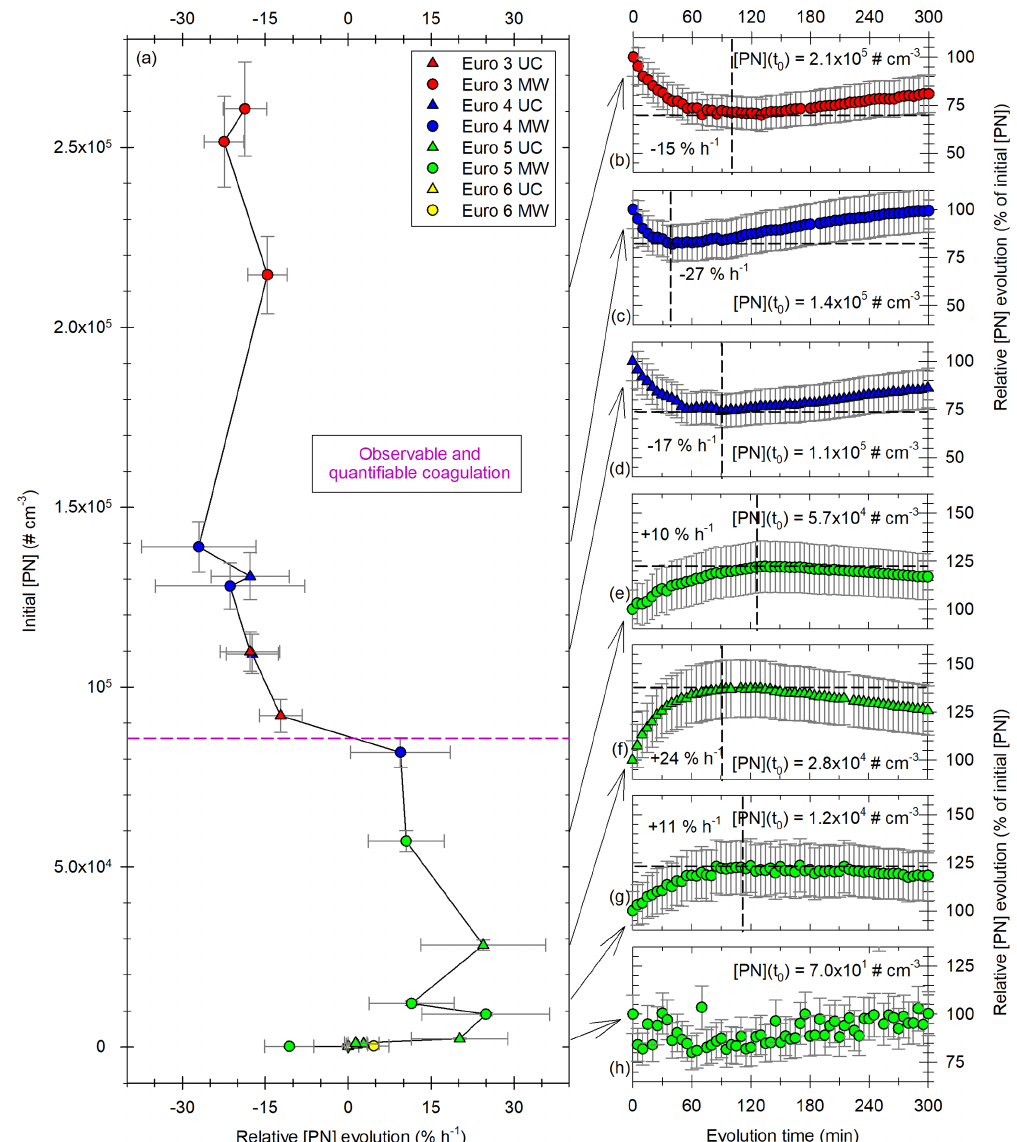
Figure 11. Evolutions of total [PN] for the vehicles of all Euro norms (Euro 3 in red; Euro 4 in blue; Euro 5 in green; Euro 6 in yellow) and in both UC (triangles) and MW (circles) driving. Panel (a) on the y axis is the initial particle concentration, plotted versus the [PN] evolution, expressed in percentage of the initial concentration per hour. The horizontal pink dashed line shows the concentration above which it is estimated that coagulation becomes observable and quantifiable with this chamber. Panels (b) to (h) show examples of such [PN] evolutions with time, expressed relatively as a percentage of initial [PN], for several initial concentrations ranging between 7.0 × 10 1 and 2.1 × 10 5 cm − 3 . The vertical dashed lines indicate the time at which the [PN] evolution stops or changes, with the percentage of initial [PN] reached at this time shown by the horizontal dashed line and with the average hourly evolution during this